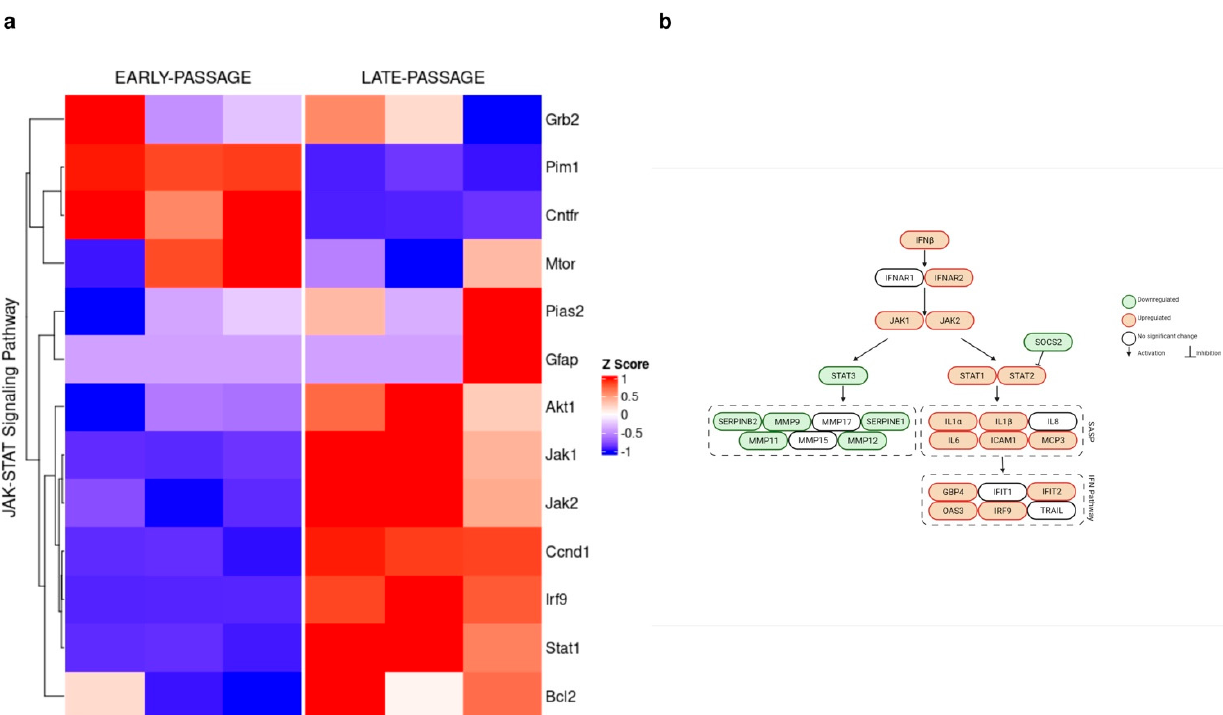
Figure 3. Differentially expressed genes between early and late BMR cells are compared. ( a ) A KEGG heatmap for the genes related to JAK–STAT signaling is shown. Upregulated and downregulated gene expressions in late BMR cells are compared to early BMR cells. The permutation of the gene set enrichment analysis is 10,000, and the cutoff p -value was selected as 0.05. The gene set enrichment scores were performed with a multiple test correction (Benjamini–Hochberg) ( n = 3). Before creating the heatmap, raw gene expression abundances were scaled at the gene level, which is represented as the Z-score. ( b ) A schematic overview of the JAK–STAT pathway and SASP is represented with downregulated and upregulated genes.